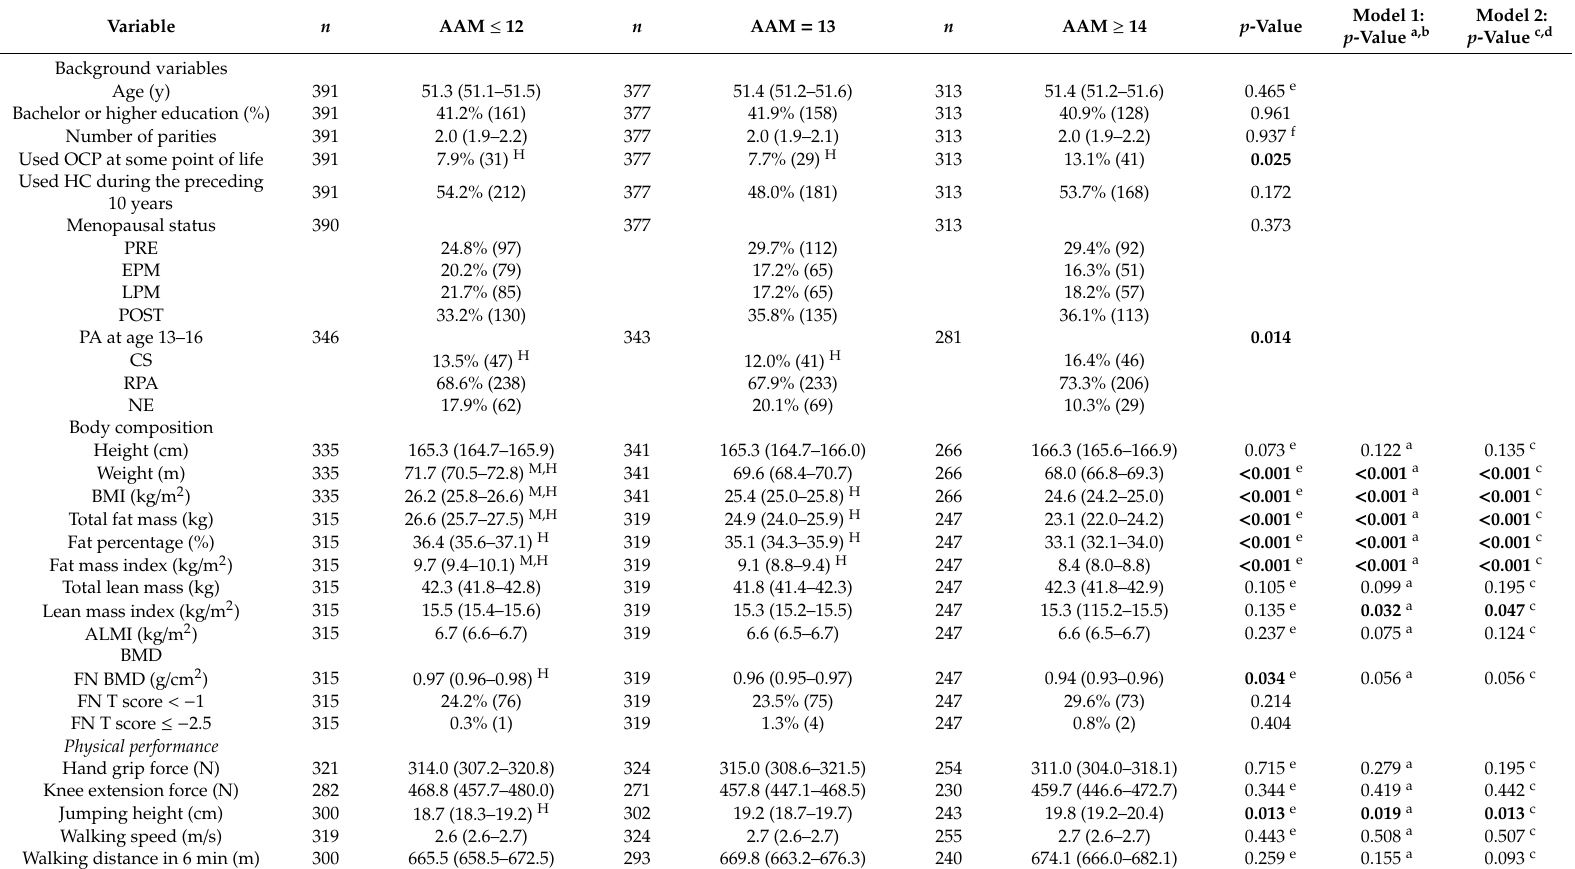
Table 3. Midlife characteristics of the participants according to di ff erent menarcheal